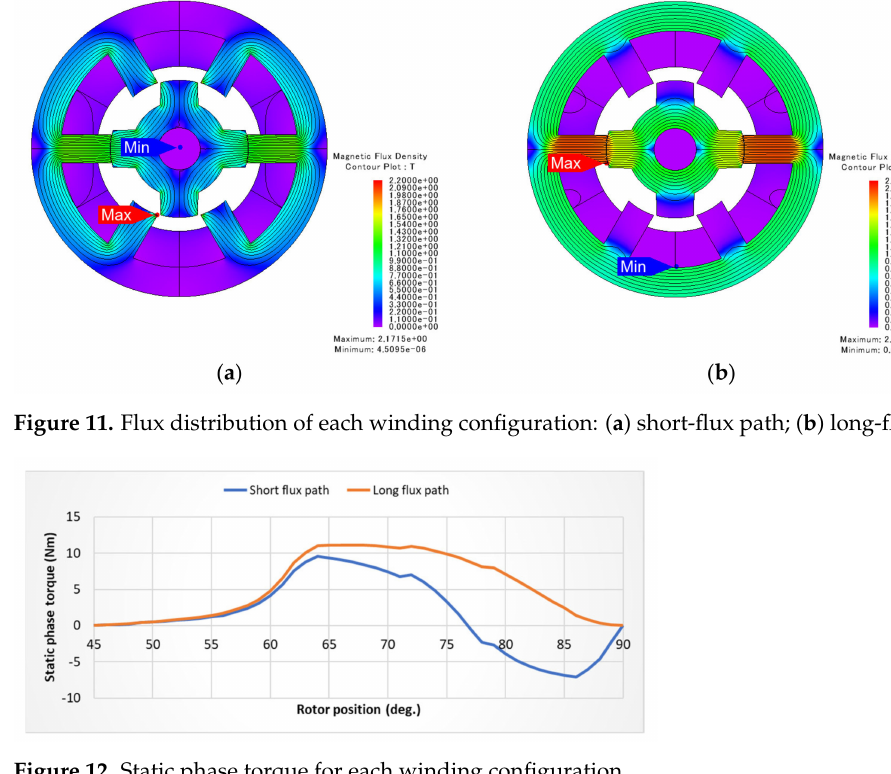
Figure 12. Static phase torque for each winding configuration.